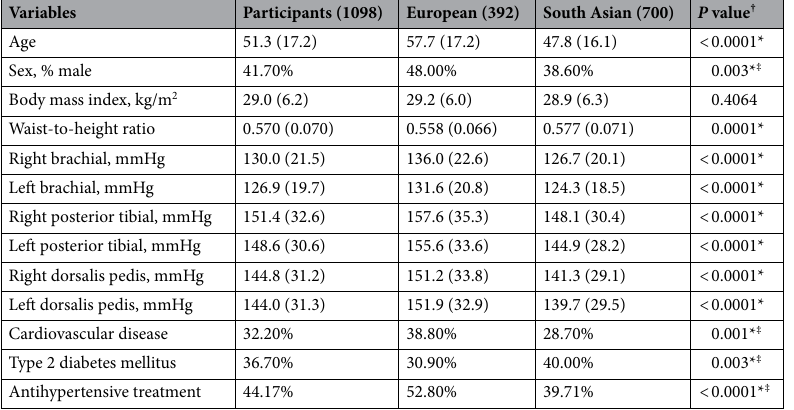
Table 1. Demographics, limb systolic blood pressures, and clinical information regarding the entire cohort, also stratified by a European or south Asian subgroup. Data is presented as mean ± standard deviation (SD) or count (n). *Statistically significant result using a P-value < 0.05. † Comparison between European and South Asian subgroups. ‡ P value calculated using a chi-squared test, rather than a